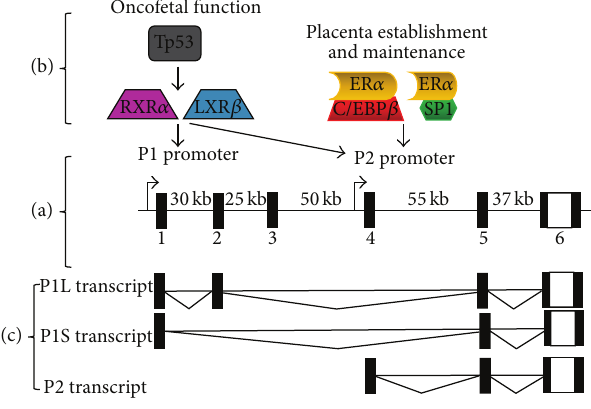
Figure 2: Human PLAC1 gene organization and transcription. (a) The genomic structure of the PLAC1 gene and the location of the two promoters are shown. Noncoding DNA is indicated by the filled boxes while the 3 󸀠 -most part of the 5 󸀠 UTR, the complete coding region, and the 3 󸀠 UTR are all contained in exon 6. The distances between the exons are also shown. (b) Transcription factors and suspected transcription influencing factors associated with the two PLAC1 promoters. (c) mRNA transcripts produced by the human PLAC1 gene that have been cloned by the authors. All three transcripts, P1L (ong), P1S (hort), and P2, have been cloned from a single reverse transcription in several instances including both endometrial and ovarian